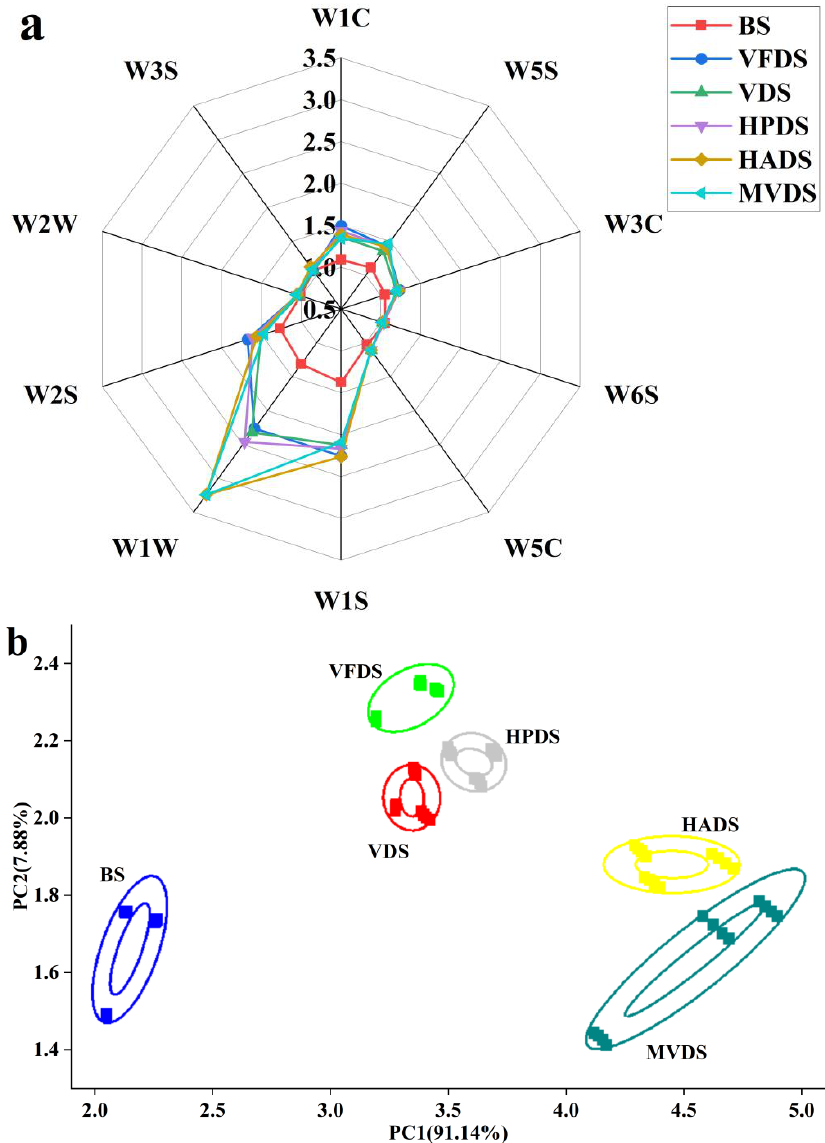
Figure 1. E-nose radar map of dried shrimps’ samples with different drying methods ( a ), PCA diagram of dried shrimps’ samples with different drying methods ( b ). BS: blanching shrimp; VFDS: freeze-dried vacuum shrimp; VDS: vacuum-dried shrimp; HPDS: heat pump-dried shrimp; HADS: hot air-dried shrimp; MVDS: microwave vacuum-dried shrimp.